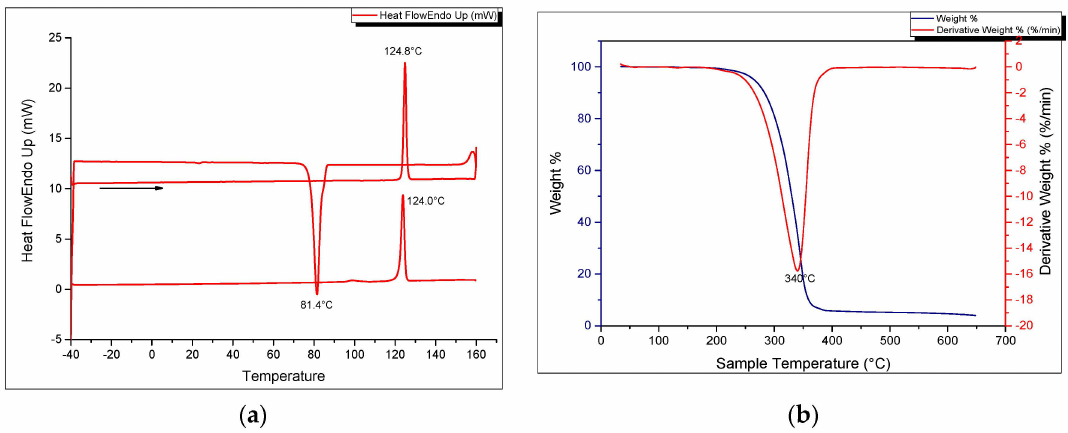
Figure 6. ( a ) DSC heating and cooling thermogram ( b ) TGA and DTG curves of the azacrown polyether